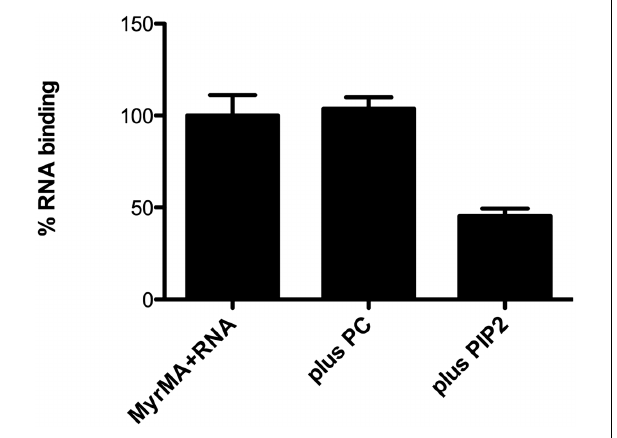
FIGURE 3 | Competition of PI(4,5)P2 liposomes for matrix protein RNA binding sites. Experiments performed by Alfadhli etal. (2011) have shown that nickel-nitrilotriacetic acid (Ni-NTA) beads coated with the myristoylated HIV-1 matrix protein (MyrMA) bind fluorescently tagged Sel25 RNA (MyrMA + RNA). Addition of liposomes composed of 80% dioleoylphosphatidyl choline + 20% cholesterol (plus PC) during binding reactions did not diminish MA–RNA binding, whereas addition of an equal amount of liposomes composed of 70% PC, 10% PI(4,5)P2, 20% cholesterol (plus PIP2) significantly reduced MA–RNA binding.These and other experiments indicate that the affinity of HIV-1 MA for RNA is less than that for membranes containing PI(4,5)P2 but greater than that for membranes without